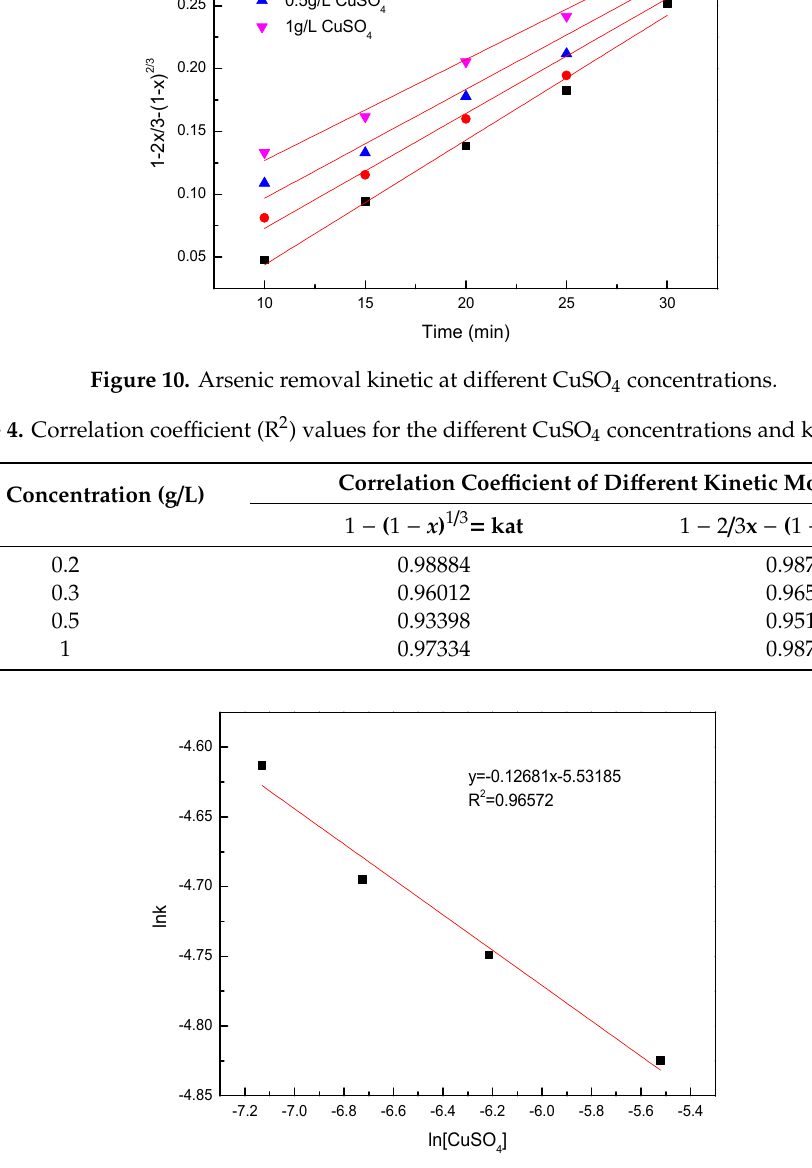
Table 4. Correlation coefficient (R 2 ) values for the different CuSO 4 concentrations and kinetic data.